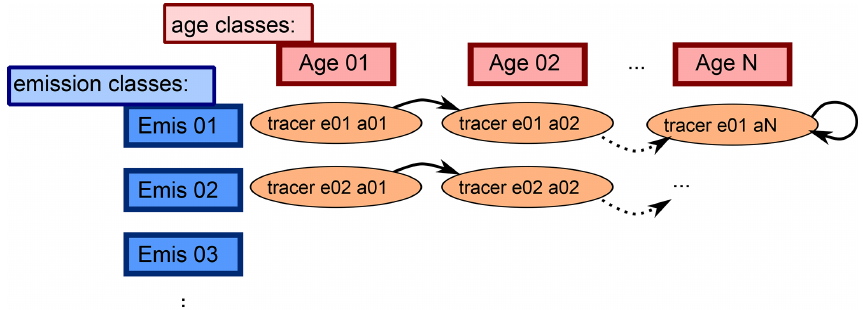
Figure 2. Sketch showing the advancing of the age classes in the CH4 submodel. Each tracer represents one specific emission and age class. After the defined length of time, the age classes proceed to the next “older” age class. The last class represents the background CH 4 , where the CH 4 is only subject to transport and the chemically defined sink reactions but is not propagated to an older age class, which is indicated by the circled